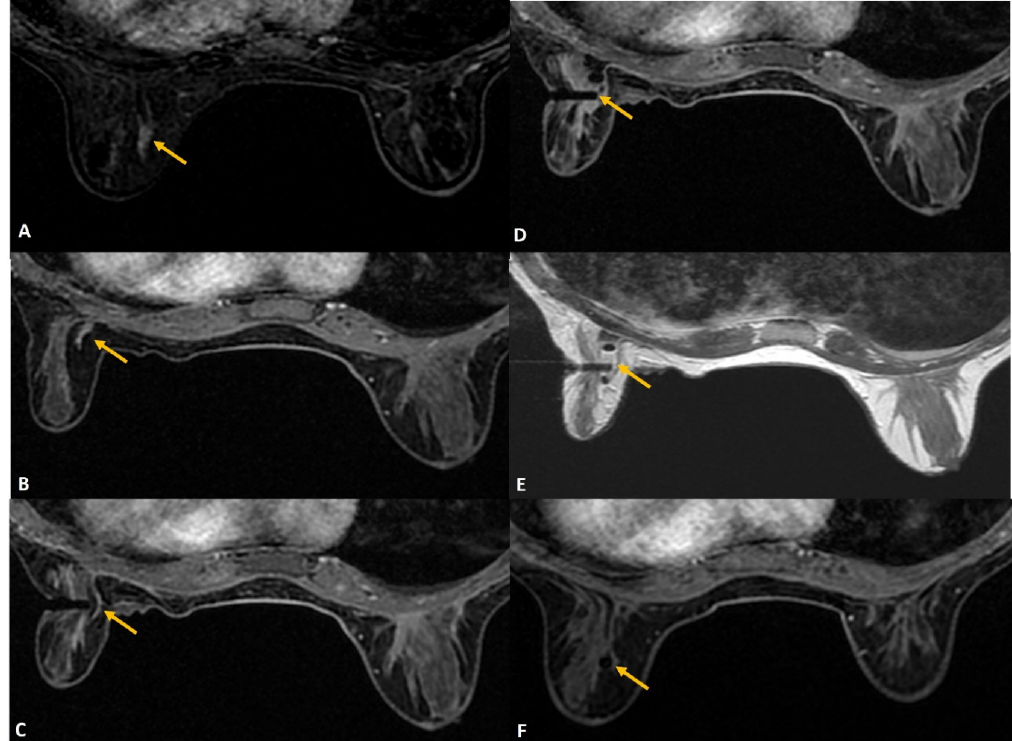
Figure 7. ( A ). High-risk screening in a BRCA 2 woman showed a new 4-mm enhancing focus in the left breast (yellow arrow). ( B ). Sagittal image on the biopsy day showed the target focus enhancing well (red circle). ( C ). During targeting, the entry point was noted to fall on the “cross” of the grid (red circle), which blocked the ideal entry site. ( D ). In this case, we performed dual-needle targeting though diagonally adjacent holes. Two obturators in these holes (white arrows) are seen adjacent to the target (red circle). Selected directed sampling through both these needles towards the target would increase the chance of getting the tiny lesion biopsied adequately. ( E ). Post biopsy hematoma cavity (yellow arrow) was seen at the target site with non-visualization of the target suggesting adequate sampling. The histology was proven as 3-mm invasive tubular carcinoma.